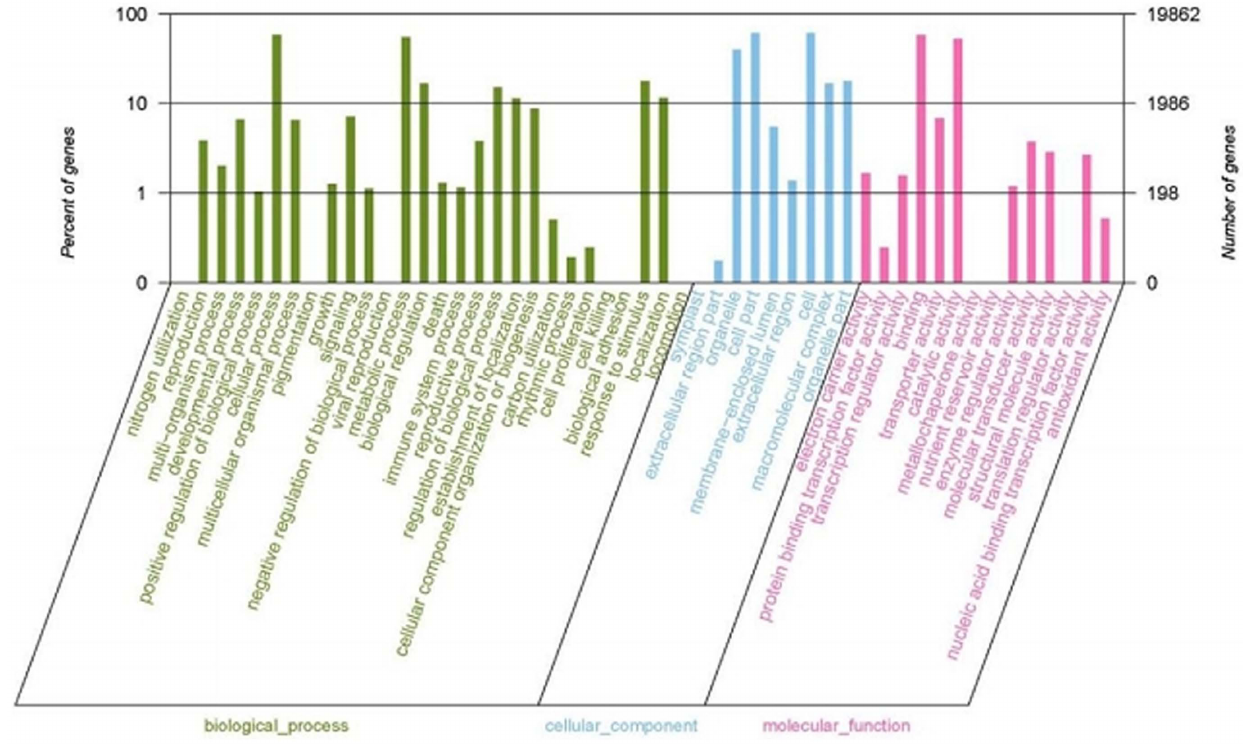
Figure 2. Functional categorization of the genes detected in sand pear pericarps. The functional categorization was performed using WEGO (Web Gene Ontology Annotation Plot).